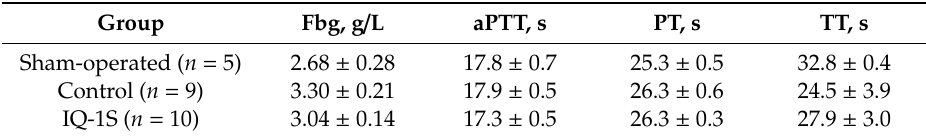
Table 6. The e ff ects of IQ-1S (50 mg / kg, i.g.) on fibrinogen (Fbg), the activated partial